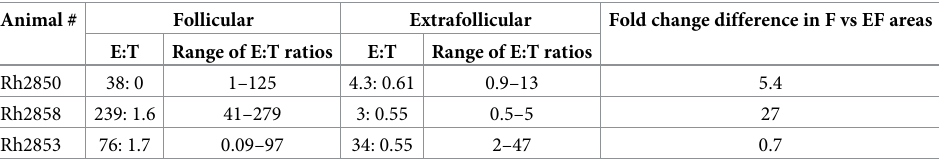
Table 3. T2 animals in vivo CAR/CXCR5 + : vRNA + E:T at 6 days post-infusion. Animal # Follicular Extrafollicular Fold change difference in F vs EF areas E:T Range of E:T